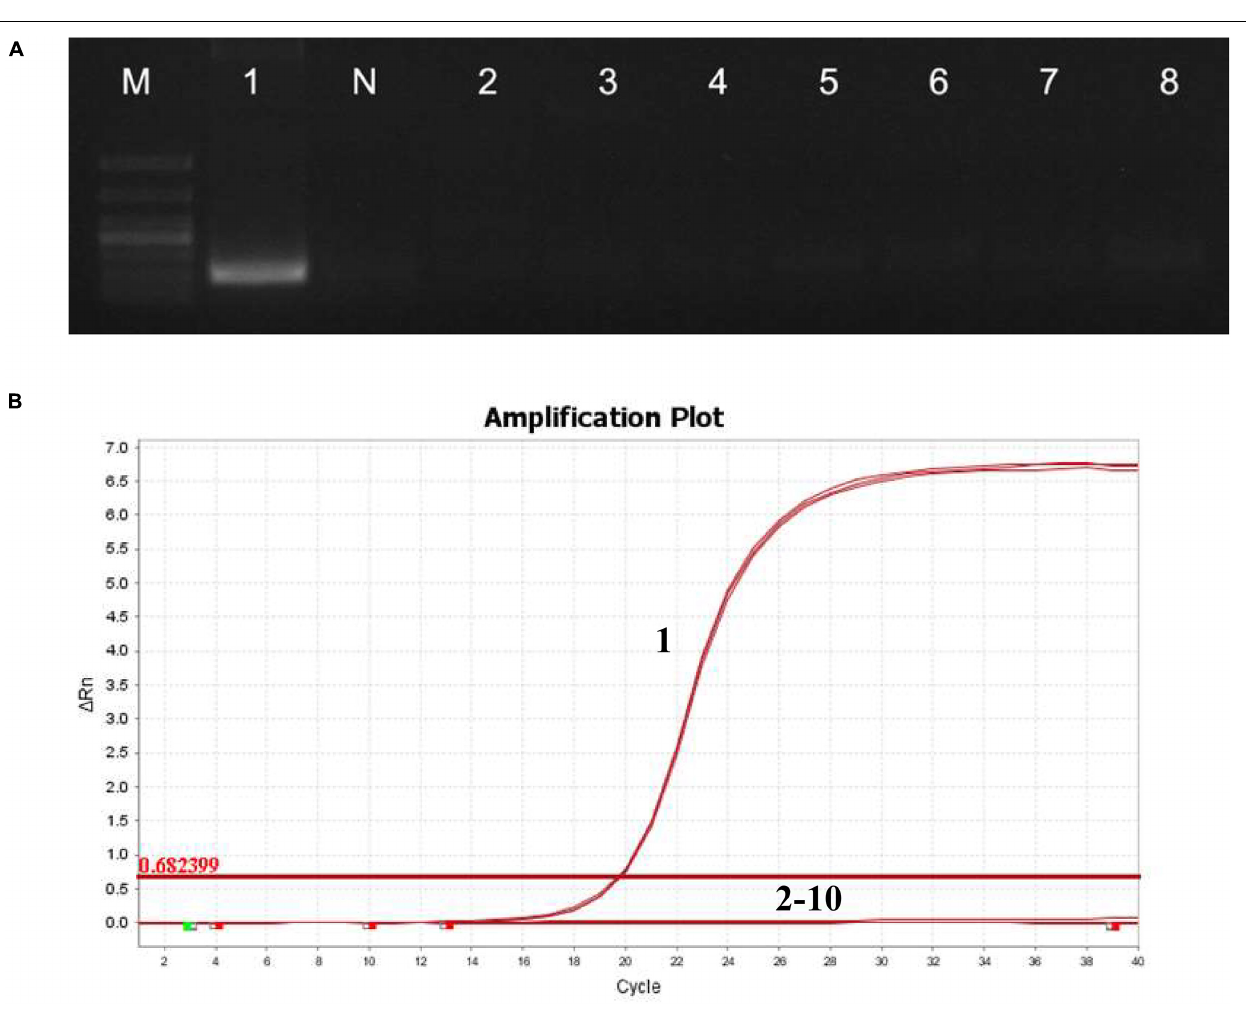
FIGURE 1 | Specificity of detection of RPS9. (A) Electrophoresis of PCR products amplified using primer RPS9. M: DL1000; 1: EAM; N: healthy shrimp hepatopancreas DNA; 2: E. hepatopenaei ; 3: H. eriocheir ; 4: M. bicuspidata ; 5: Microsporidia sp.; 6: P. putida ; 7: V. parahaemolyticus ; and 8: white spot syndrome virus. (B) Specificity of qPCR amplification curve of RPS9. 1: EAM; 2: E. hepatopenaei ; 3: H. eriocheir ; 4: M. bicuspidata ; 5: Microsporidia sp.; 6: P. putida ; 7: V. parahaemolyticus ; 8: white spot syndrome virus; 9: healthy shrimp hepatopancreas DNA; and 10: